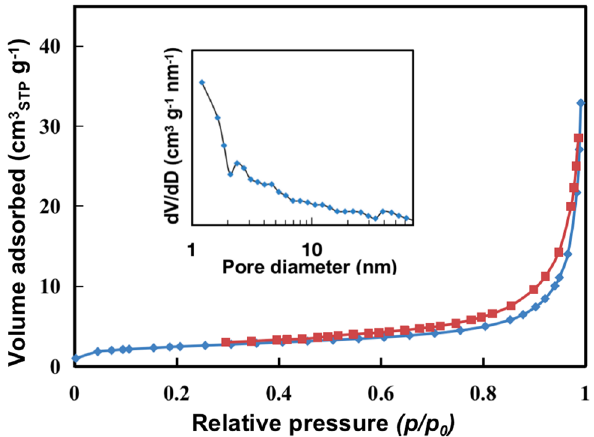
Figure 3. N 2 adsorption–desorption isotherms of carbon ferrite and the inset showing the pore size distribution.